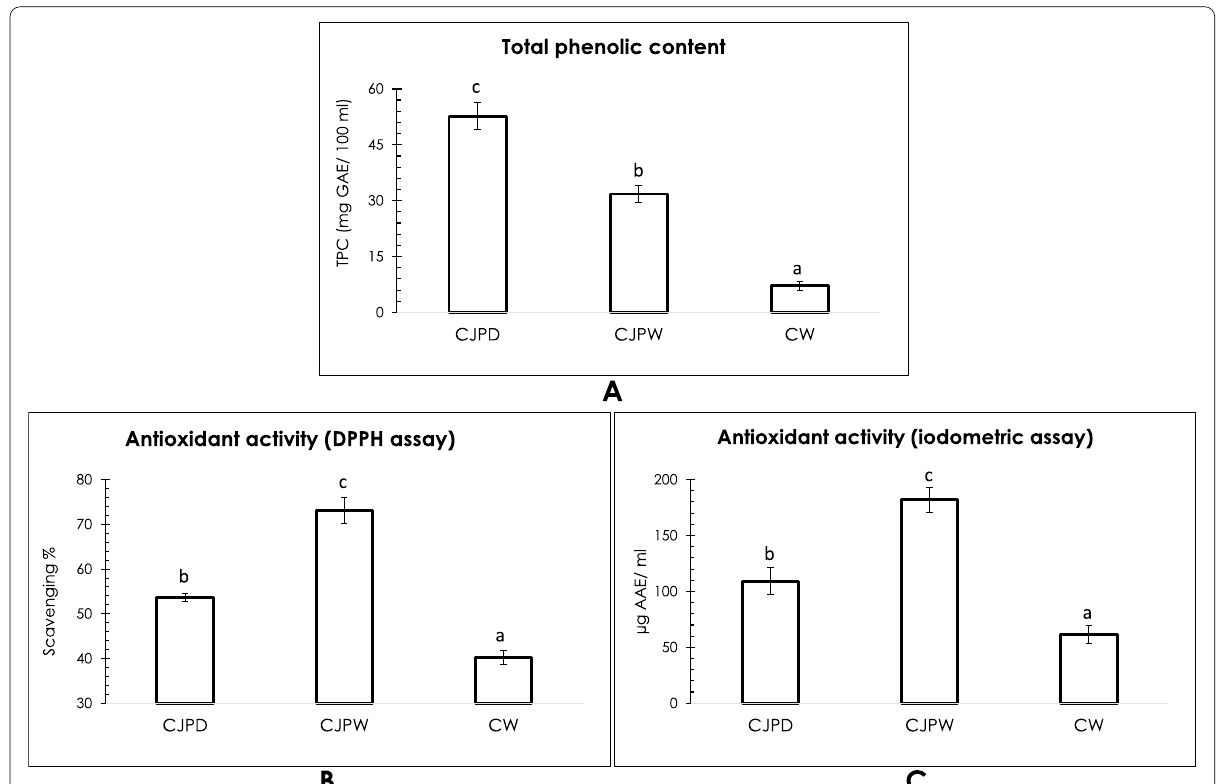
Fig. 3 A Results of total phenolic content or TPC; B Results of in vitro antioxidant activity (DPPH assay); and C Results of in vitro antioxidant activity (iodometric assay). Values are means standard deviation, means with different superscripts in each figure are significantly different ( P < 0.05). GAE: ± gallic acid equivalent; AAE: ascorbic acid